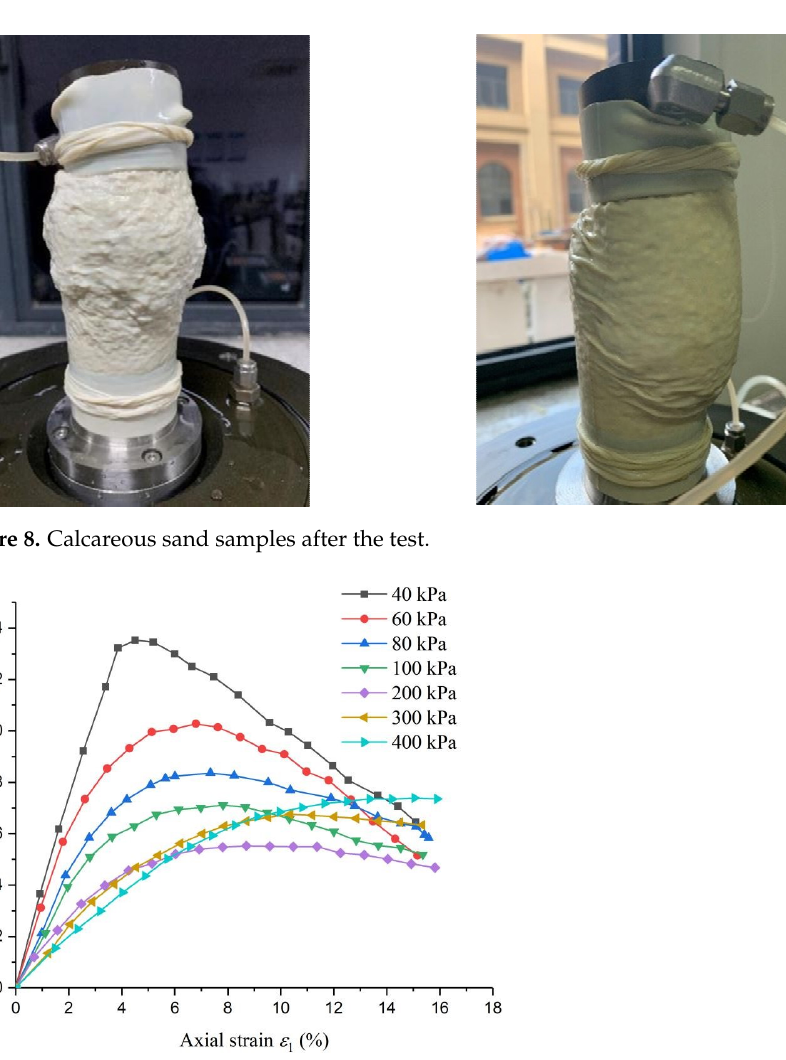
Figure 9. Effective stress–axial strain ratio curve of calcareous sand in tri-axial CD tests.